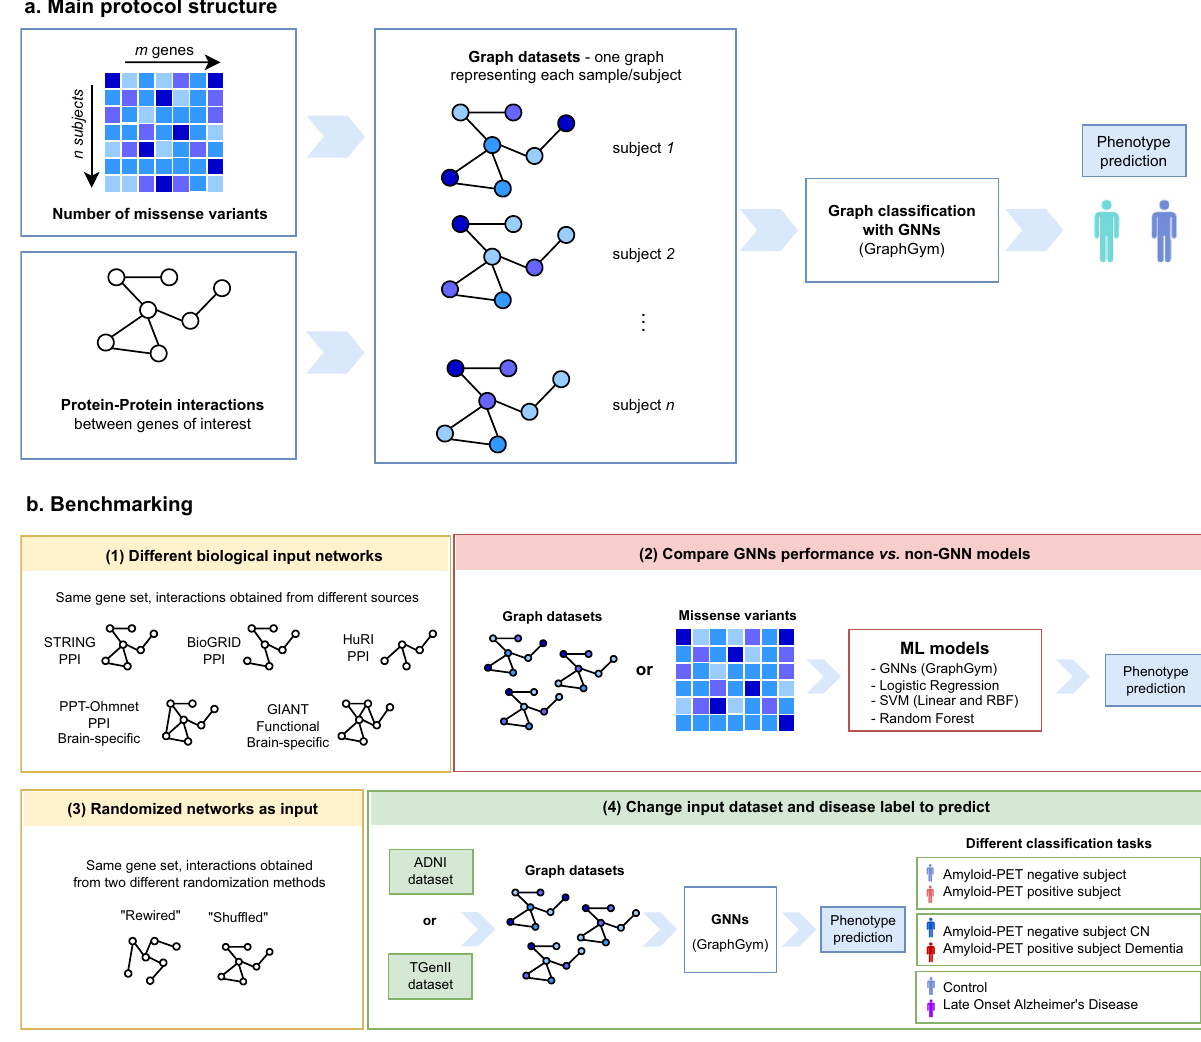
Figure 1. ( a ) Overview of the workflow for phenotype prediction through genotype data. Starting with a set of genes of interest to study, we extracted the number of missense variants in each gene in a genetic cohort and built a protein–protein involving these genes. With the input networks and genetic data, we built different graph datasets, in which each graph represented a sample, including the number of missense variants as node attributes. These graph datasets are lastly used as input for phenotype prediction using Graph Neural Networks (GNNs), evaluated on a framework called GraphGym 12 . ( b ) Overview of the benchmarking. We compared the performance of GNNs (1) using graph datasets coming from different biological networks, (2) against other non-GNN models using the number of missense variants, (3) using graph datasets coming from randomized networks, and (4) for predicting of several labels from different input